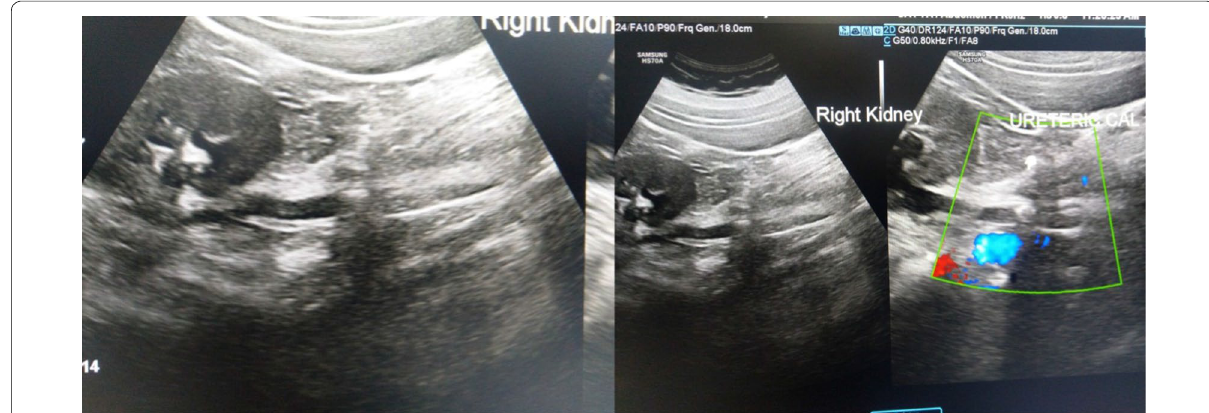
Fig. 2 Right ureteric stone detected by transabdominal ultrasound in pregnant